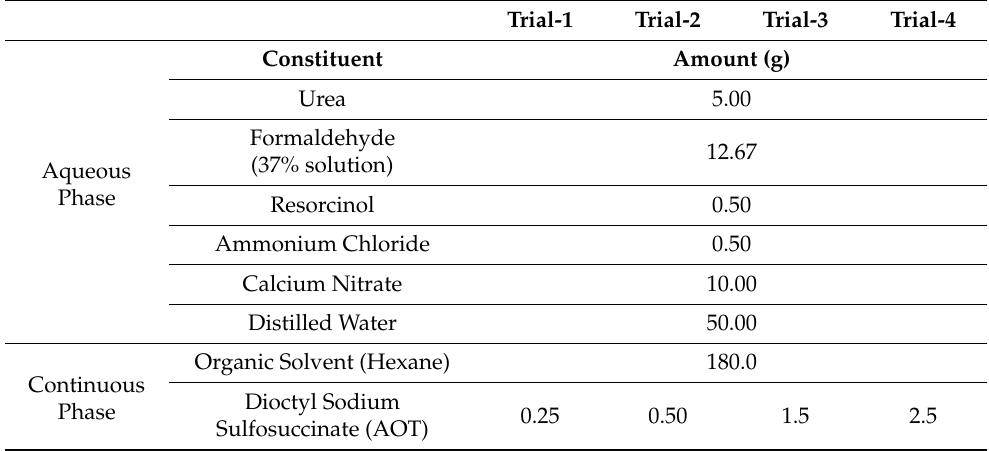
Table 1. The compositions of all microcapsule preparation